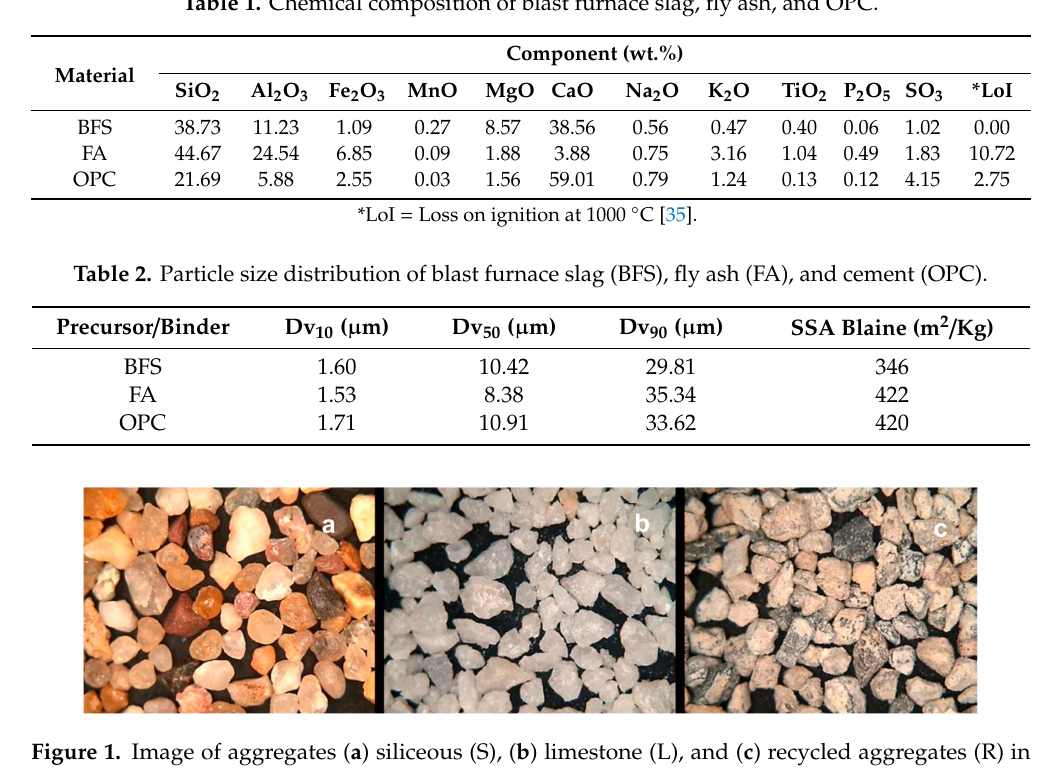
Table 1. Chemical composition of blast furnace slag, fly ash, and OPC.